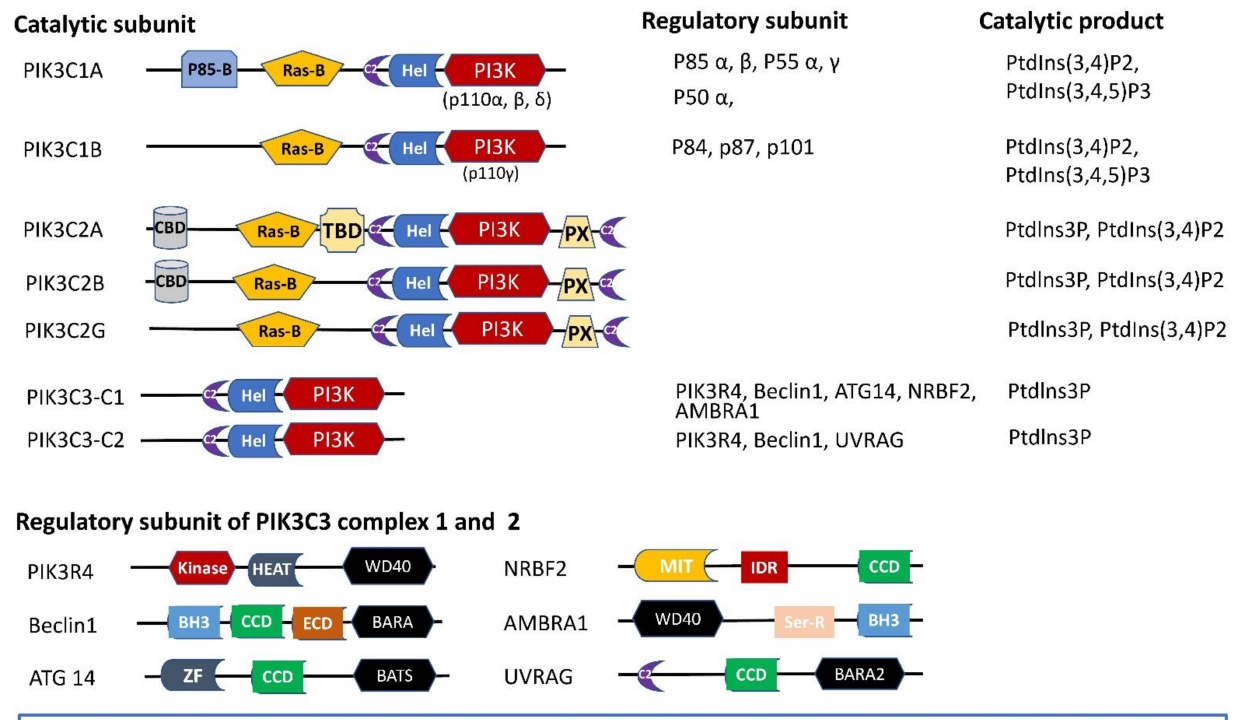
Figure 1. Structure of the catalytic and regulatory subunits and catalytic products of PI3K family